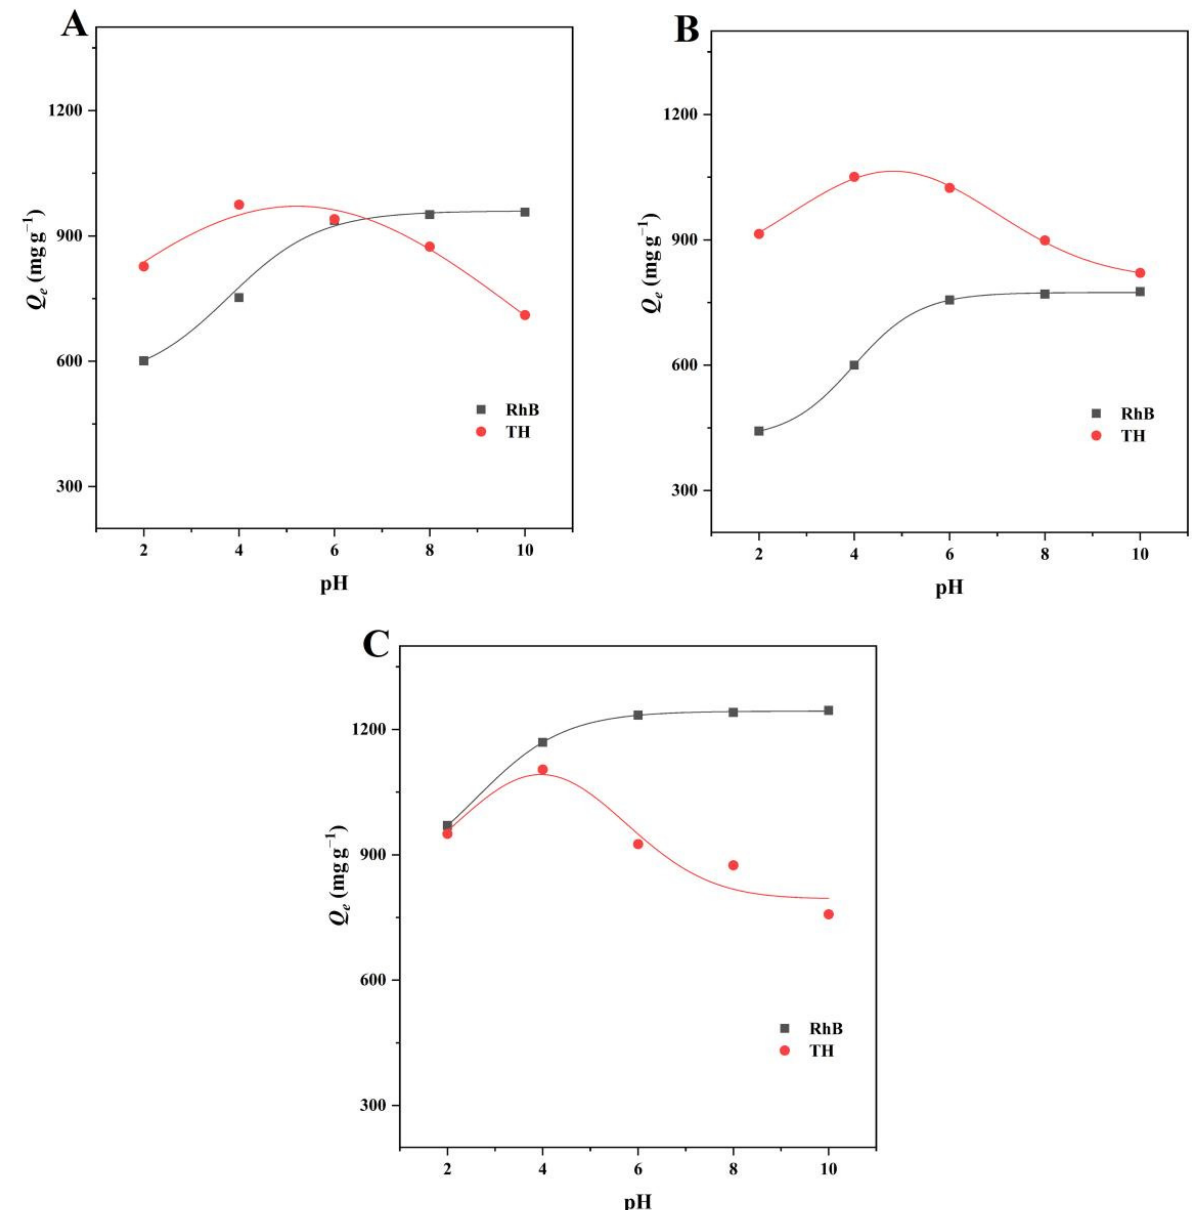
Figure 9. The effect of pH on the adsorption capacities of ( A ) BMCD-K, ( B ) BMCD-Na, and ( C ) BMCD-MB.